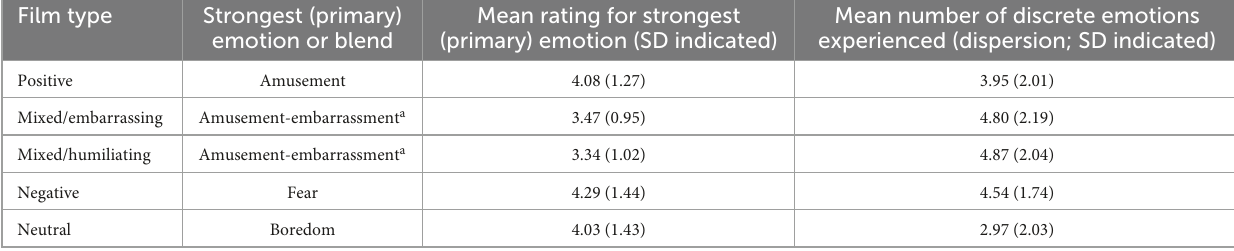
TABLE 2 Mean ratings for the primary emotion and mean dispersion score for each of the five film types. Film type Mean rating for strongest (primary) emotion (SD